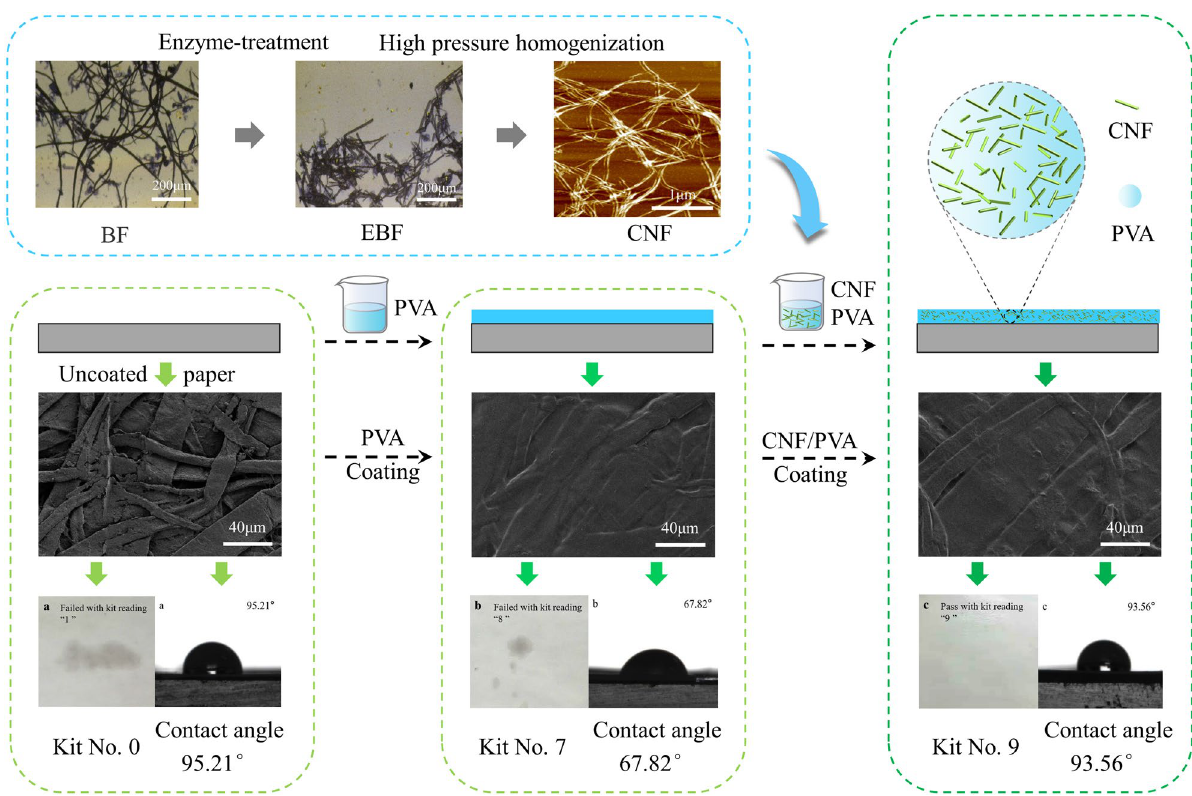
Figure 1. The preparation process and properties of PVA/CNF coated